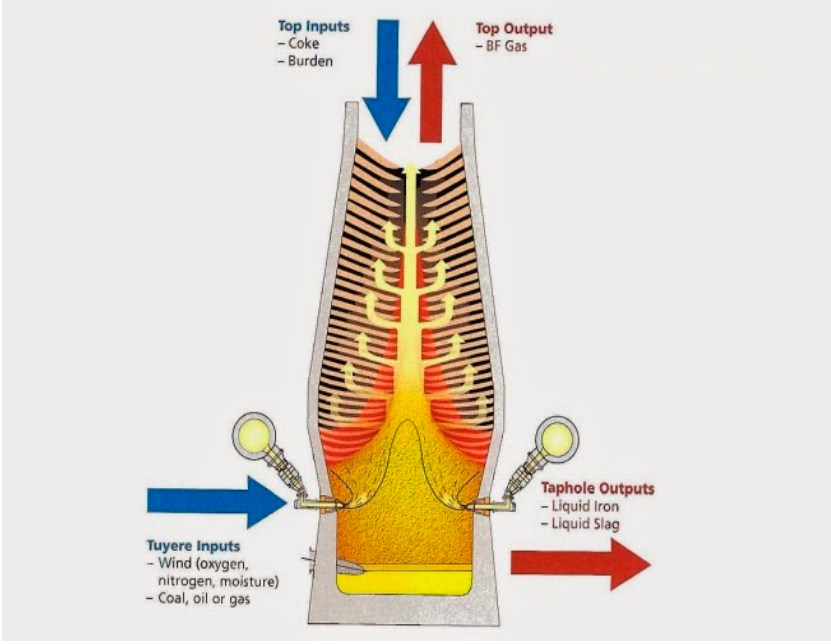
Figure 2. Input and output of modern BF (adopted with permission from [21]).